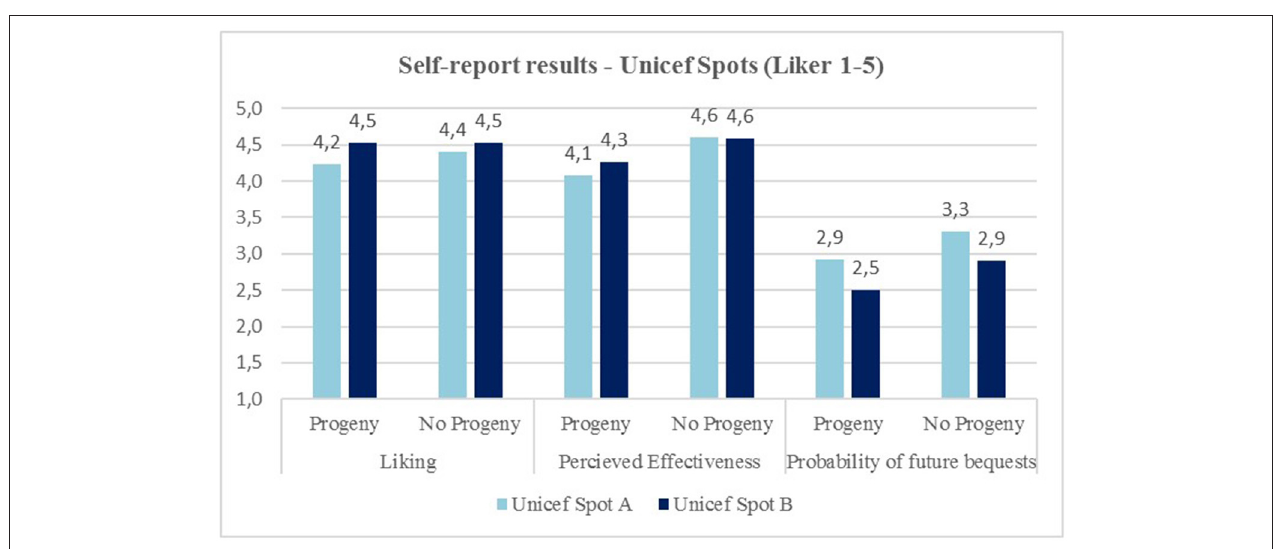
FIGURE 7 | Self-report results on UNICEF